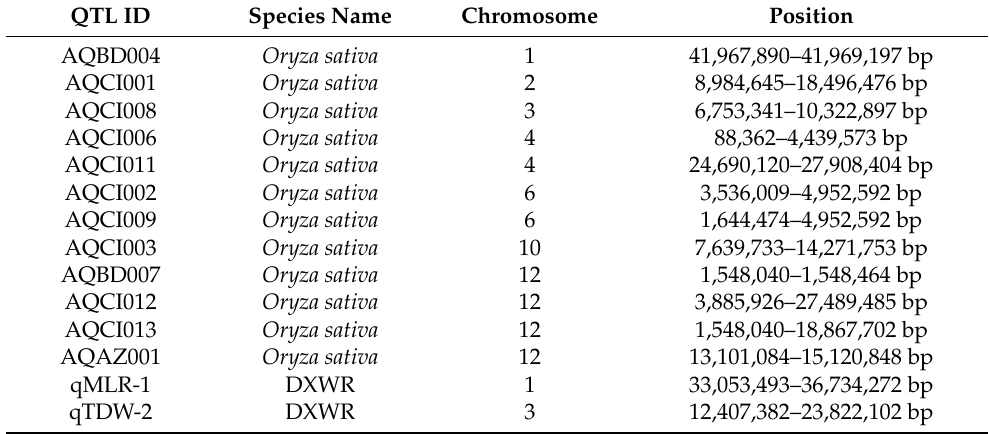
Table 4. Previously identified P-deficiency responses related to QTL intervals.